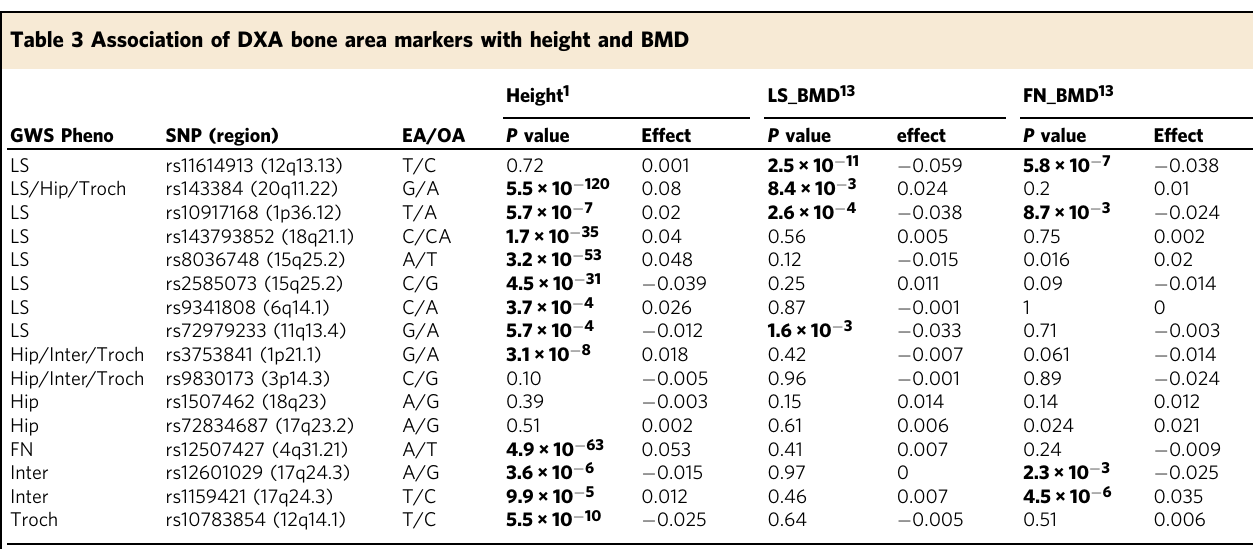
associations (Supplementary Table 8). The negative correlation- with hip BMD may re fl ect the periosteal expansion observed with age 42 that is not captured by age adjustments of the measures used. Likewise, the positive correlation between lumbar